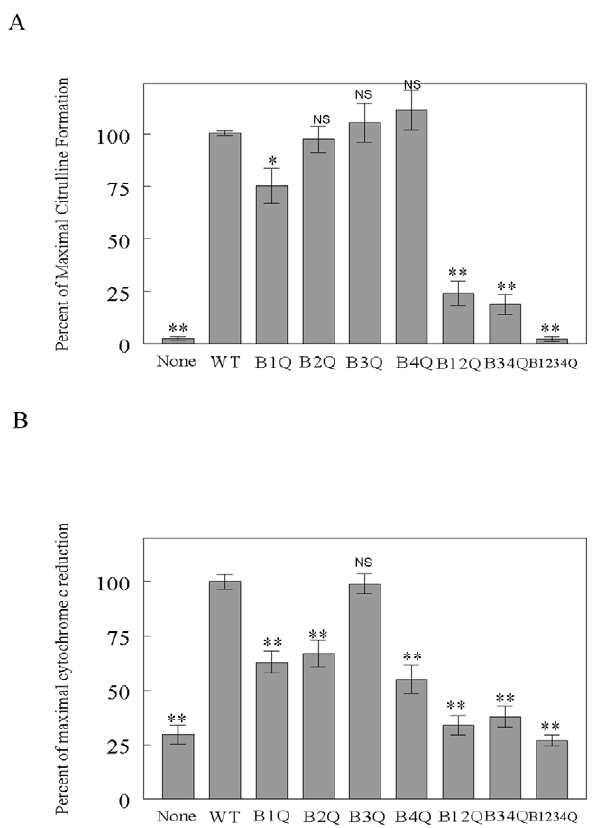
Figure 3. Ability of various CaM mutants to activate eNOS enzymes. A: Citrulline formation activity. B: Cytochrome c reduction activity. Both citrulline formation and cytochrome c reduction were measured in the presence of saturating concentration of each CaM construct (0.5 m M). NOS activities were expressed as percentage of the respective maximal NOS activity (100%) which was obtained with the eNOS bound to wild-type CaM. Under these conditions, the activities for eNOS bound to wild-type CaM were , 14 min 2 1 for citrulline formation, and , 286 min 2 1 for cytochrome c reduction. Data are presented as means 6 standard deviation. * denotes p , 0.05, ** , 0.01, NS, not significant difference as compared to wild-type CaM. Each experiment was performed in triplicate and repeated three